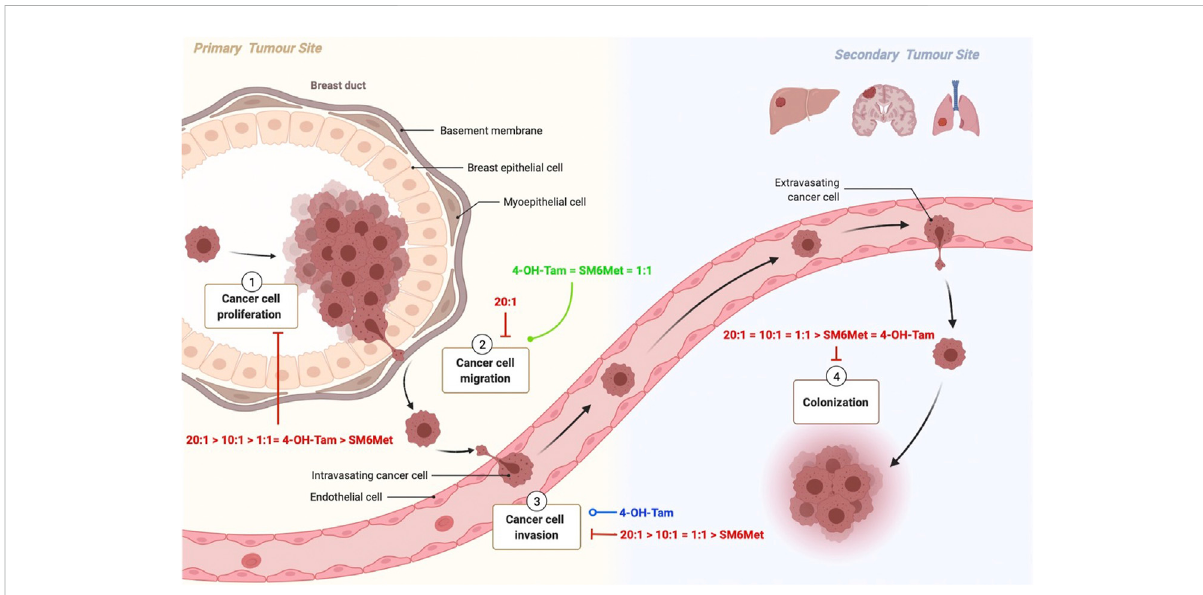
FIGURE 7 Schematic summary of the effects of the combinations of SM6Met with 4-OH-Tam compared to SM6Met alone and 4-OH-Tam alone on the processesinvolvedinbreastcancerproliferationandmetastasis.Breastcancercarcinogenesis encompassesvarioussteps,eachofwhichpresentan opportunity for new therapies. Carcinogenesis is characterized by uncontrolled cell proliferation 1), which leads to the acquisition of speci fi c properties which allow the tumour cell to detach, migrate 2) and invade 3) local tissue to ultimately enter into the circulation, travel to distant organs and form colonies 4) at the secondary tumour site. Although most tumour cells circulate as single cells, others travel as clusters that include stromal cells, neutrophils, and platelets, which is more likely to form metastasis. Here the red solid line indicates the inhibiting effects of